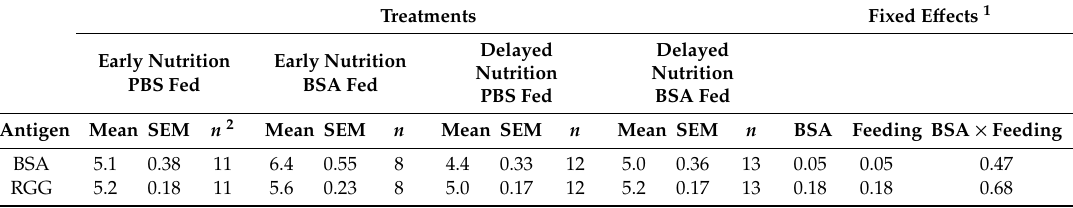
1 Model established p -values for fixed e ff ect of BSA-feeding, feeding strategy, and their interaction. 2 Number of replicate broilers, housed with 4–5 broilers per pen.